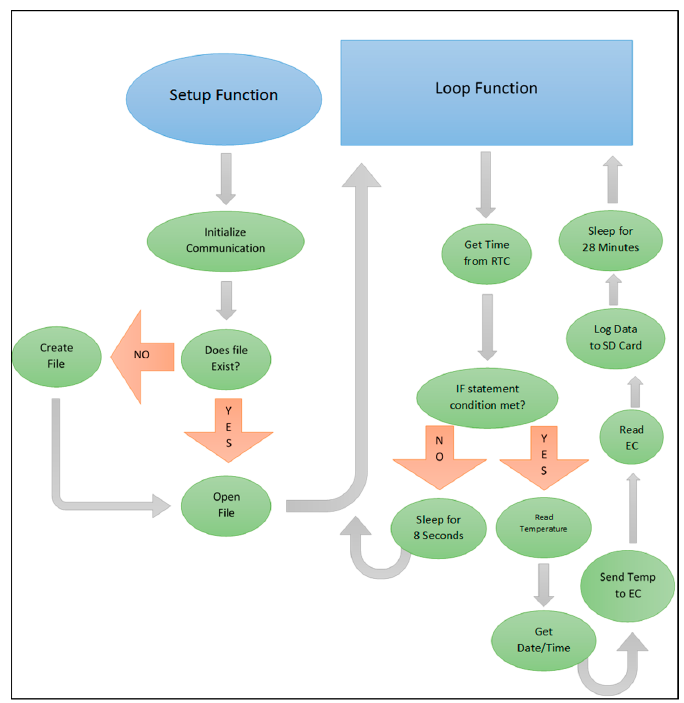
Figure 5. Programming logic followed by the sonde used for the moored application.